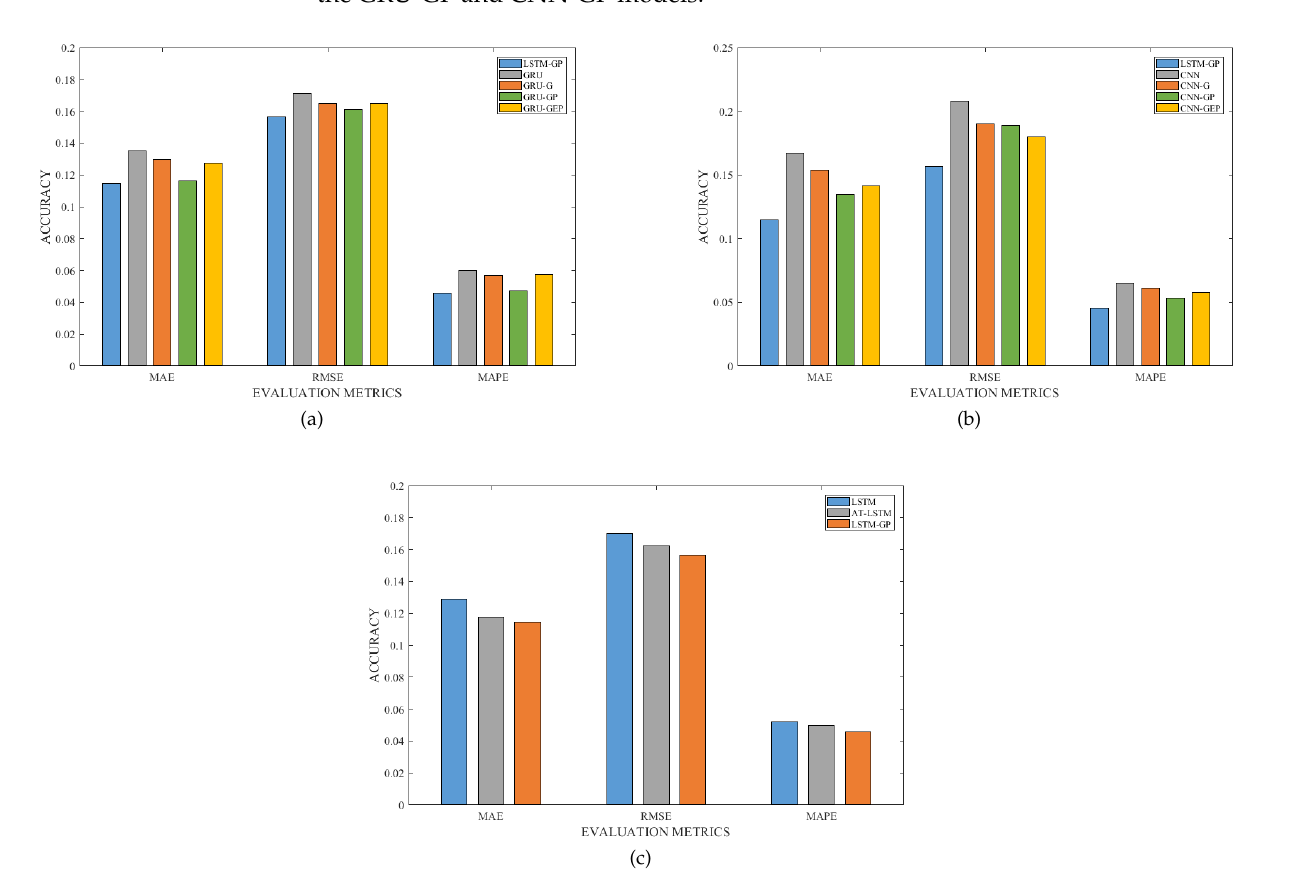
Figure 9. Comparison of MAE, RMSE, and MAPE among the proposed optimal model, the GRU– GARCH models, the CNN–GARCH combined models, and the attention–LSTM model. ( a ) Com- parison between the proposed optimal model and the GRU–GARCH family combined